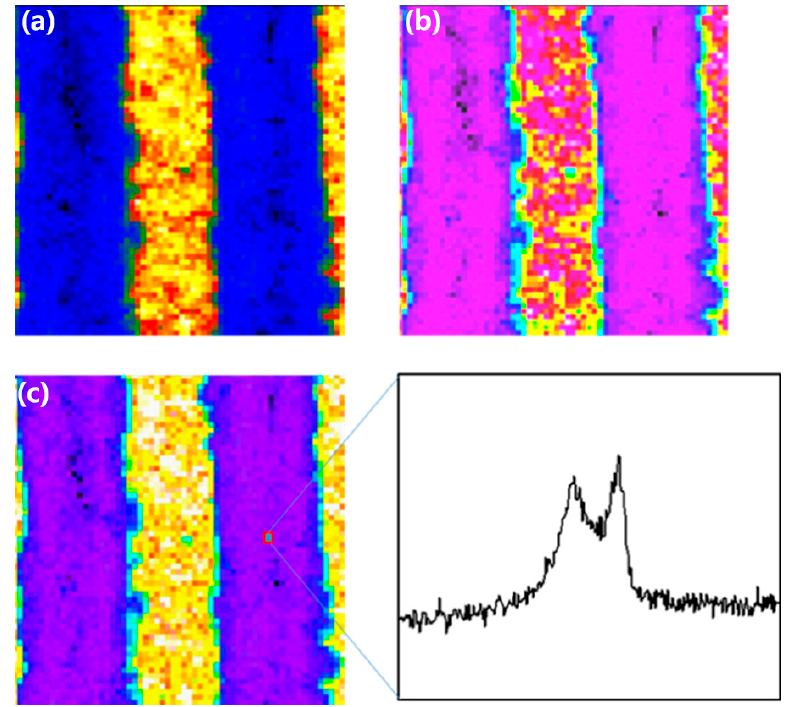
Figure 9. Raman mapping of energy density is 22 J/m 2 : ( a ) I D , ( b ) I G , ( c ) I D + I G .